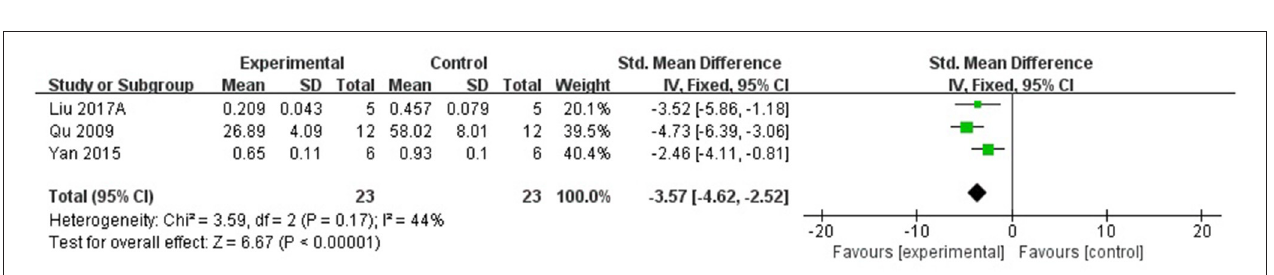
FIGURE 9 | The forest plot: effects of Rhodiola rosea L. for decreasing caspase-3 compared with control